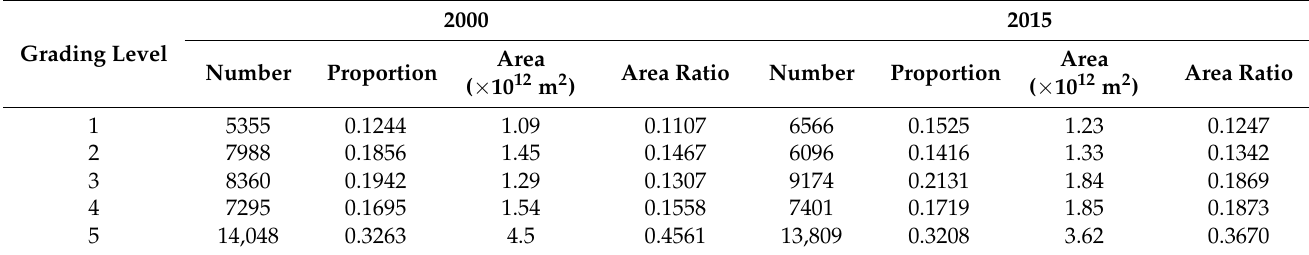
Table 6. Detailed information on the villages and towns at each grading level.